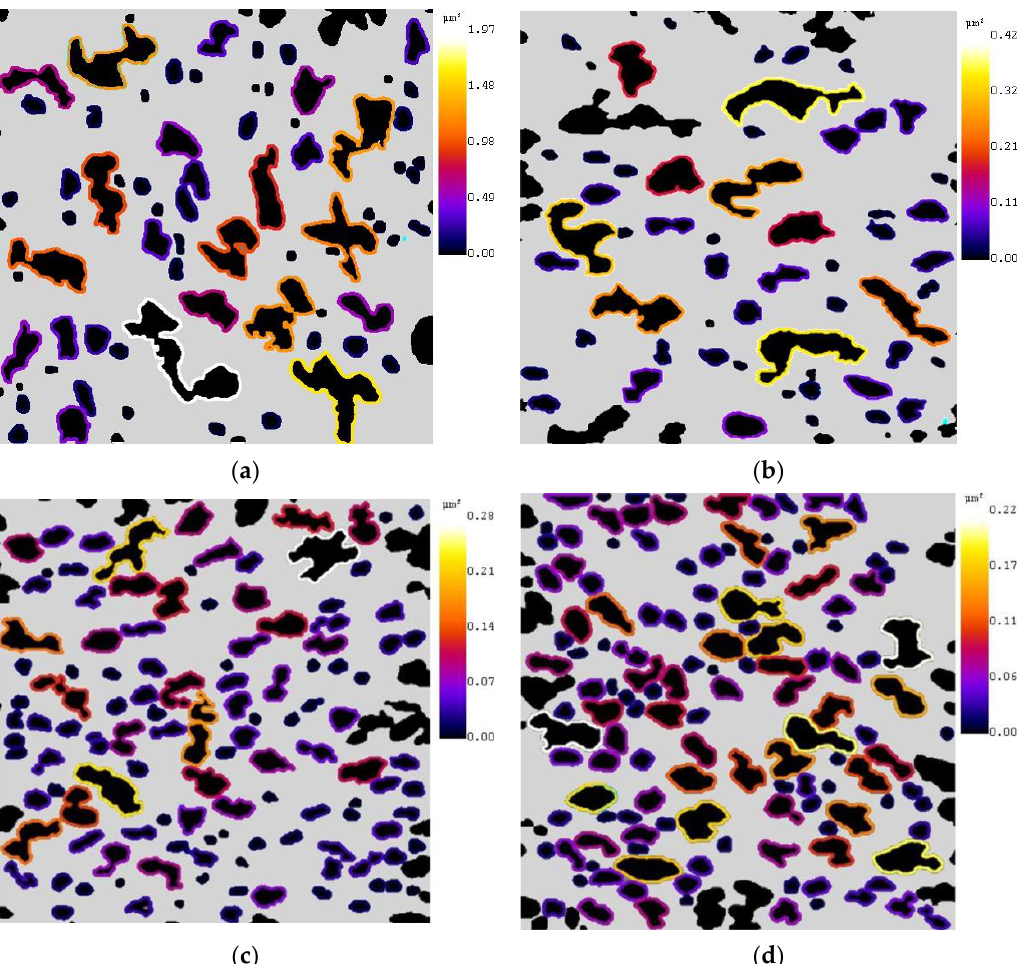
Figure 5. Surface area of flat sections of Fe 3 C after deformation with strain rate: ( a ) 0.001, ( b ) 0.01, ( c ) 0.1, ( d ) 1 s −1 .